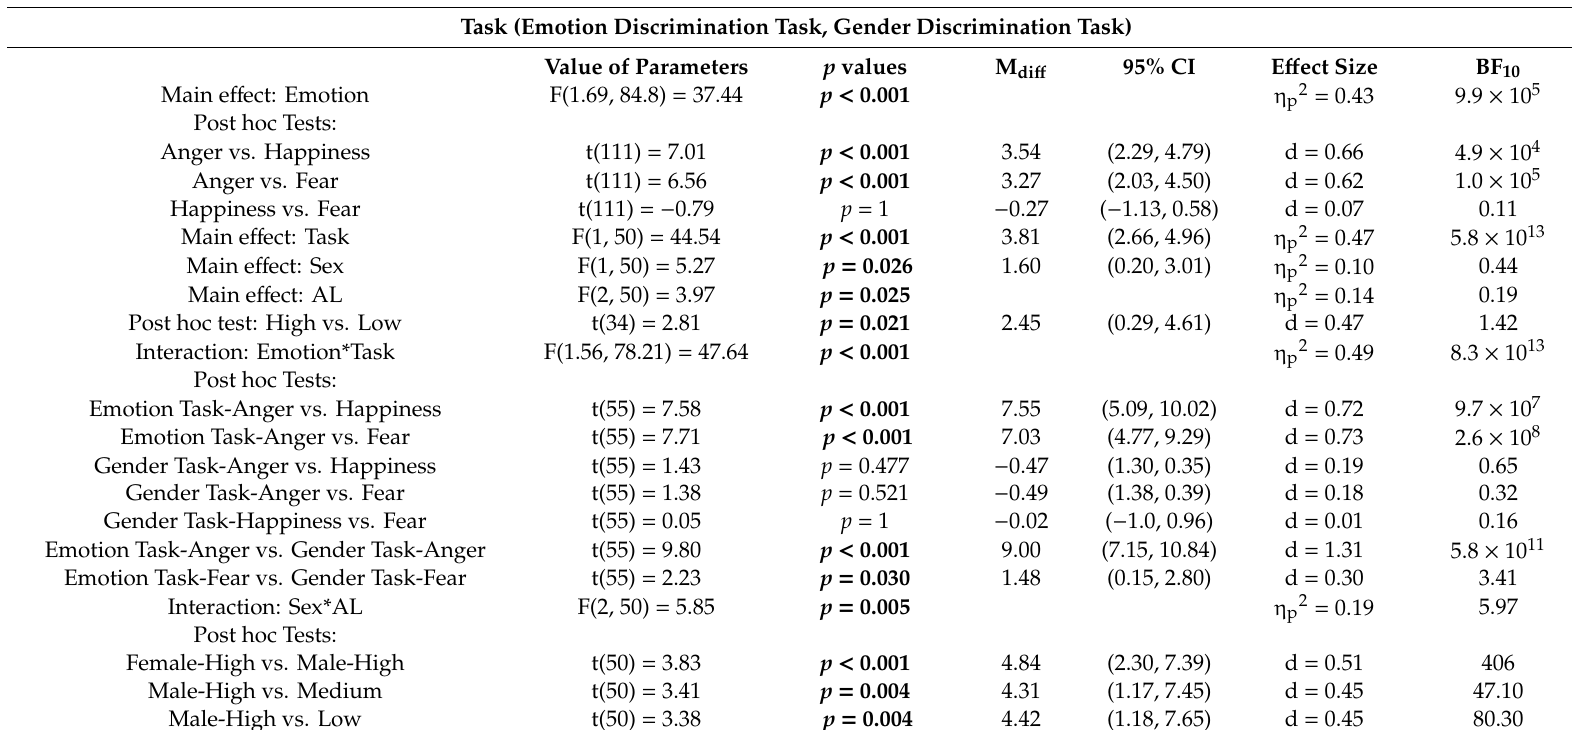
Table 4. Results of the statistical analysis on the percentage of mistakes. Post hoc tests (pairwise comparisons) had an adjusted alpha level corrected according to Bonferroni. Statistically significant results are reported in bold. Bayes factors report the ratio of likelihood of the alternative hypothesis to the likelihood of the null hypothesis (BF 10 ). ANOVA, analysis of variance. Measures of size e ff ects: η p2 for ANOVAs and Cohen’s d for post hoc tests. Di ff erences of the estimated marginal means (M di ff ) are reported along their 95% confidence interval (CI). AL, arousal